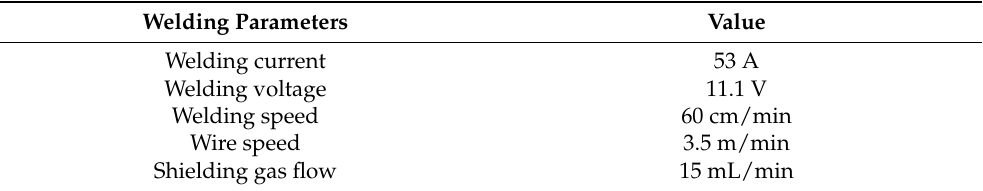
Table 2. Welding experiment parameters.